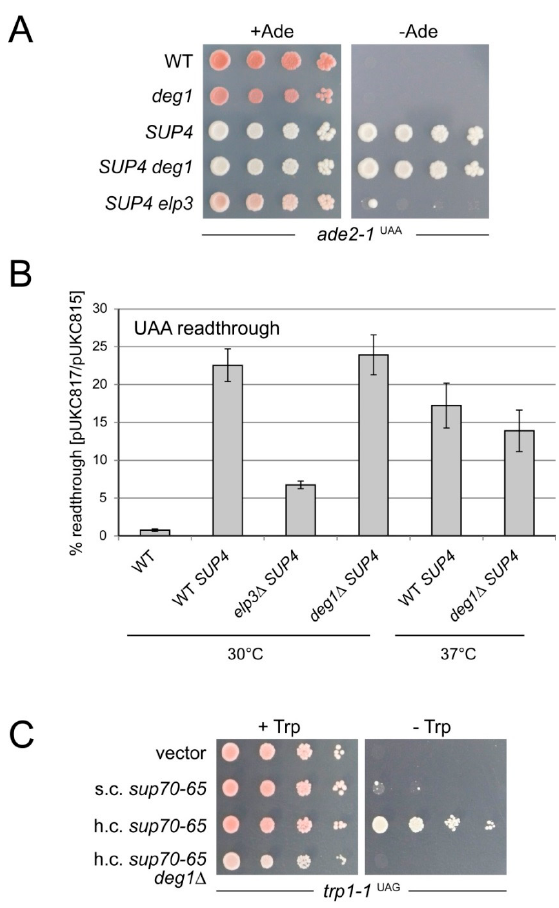
Figure 4. Role of ψ 38/39 for non-sense suppression by SUP4 or sup70-65 . ( A ) SUP4 -mediated read-through of ade2-1 . WT: Strain W303-1B, lacking SUP4 ; deg1 : DEG1 deletion in W303-1B; SUP4 : strain UMY2893, carrying SUP4 ; SUP4 deg1 : deletion of DEG1 in UMY2893; SUP4 elp3 : deletion of ELP3 in UMY2893. Serial dilutions were spotted on adenine-free (-Ade) or adenine-containing medium (+Ade); ( B ) Quantitative SUP4 -mediated lacZ read-through assay. Strains as described in ( A ) were transformed with pUKC815 and pUKC817 and relative read-through levels measured as described in Materials and Methods. 30 ◦ C and 37 ◦ C indicate growth temperatures. Averages of at least three biological replicates are shown along with standard deviation; ( C ) sup70-65 -mediated read-through of trp1-1 . Strain W303-1B or W303-1B deg1 was transformed with empty vector (vector), single-copy (s.c.) or high-copy (h.c.) constructs with the sup70-65 allele of tQ(CUG) . The ability of strains to